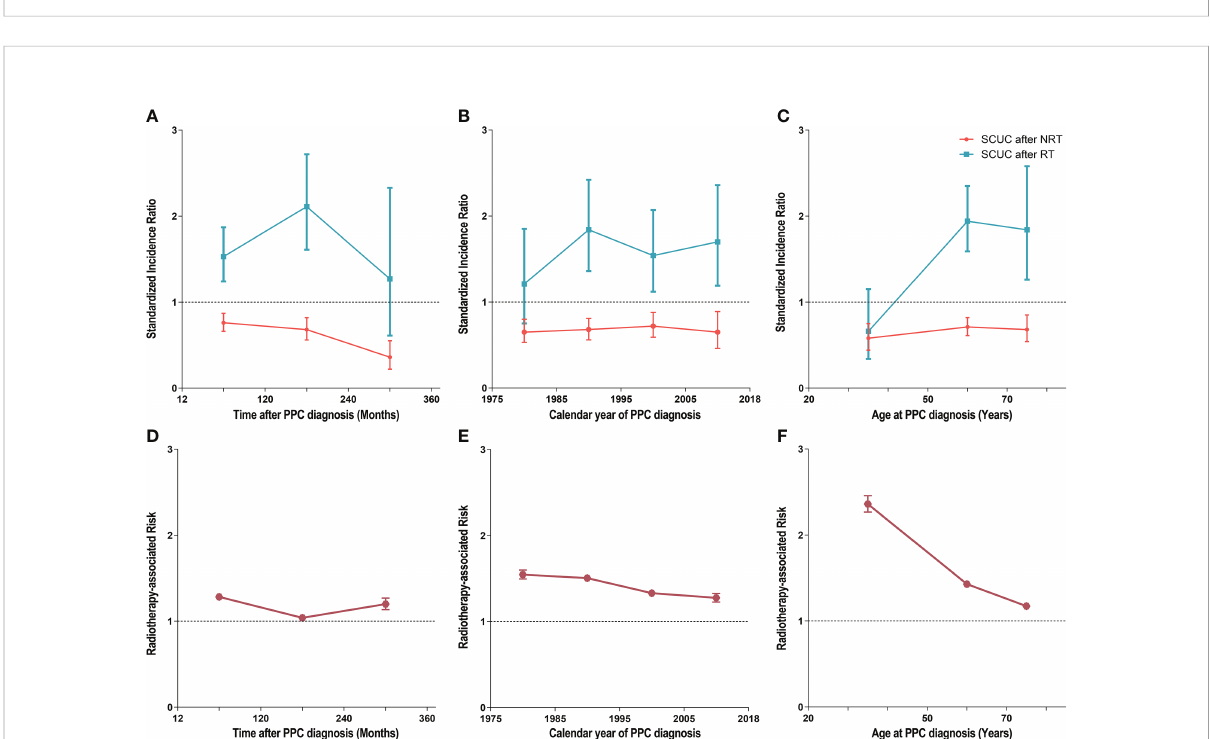
FIGURE 4 (A) Dynamic standardized incidence ratio (SIR) for secondary corpus uteri cancer (SCUC) in the latency-SIR plot. (B) Dynamic SIR for SCUC in PPC diagnosis time-SIR plot. (C) Dynamic SIR for SCUC in PPC diagnosis age-SIR plot. (D) Dynamic radiotherapy-associated risk (RR) for SCUC in the latency-RR plot. (E) Dynamic RR for SCUC in PPC diagnosis time-RR plot. (F) Dynamic RR for SCUC in PPC diagnosis age-RR plot. (A – C) Adjusted SIRs and 95% CIs of developing SCUC in primary pelvic cancer (PPC) patients treated with RT versus the US general population are plotted, as well as PPC patients who did not receive RT versus the US general population, and the incidence in the background US population is represented by the gray line (at y = 1). The detailed data of SIRs are shown in Supplementary Table 2. (D – F) The RR was estimated by Poisson regression analysis with the relative risks and 95% CIs of SCUC in primary PPC patients who underwent RT compared with those who did not undergo RT. The RR was adjusted for age at PPC diagnosis and calendar year of PPC diagnosis. In our study, the high risk of developing SCUC from RT required both adjusted HR >1 and adjusted RR >1, and the low risk of developing SLC from RT required both adjusted HR <1 and adjusted RR <1. RT, radiation therapy; NRT, no radiation therapy; RR, radiotherapy-associated risk; SIR, standardized incidence ratio; SCUC, secondary corpus uteri cancer; PPC, primary pelvic